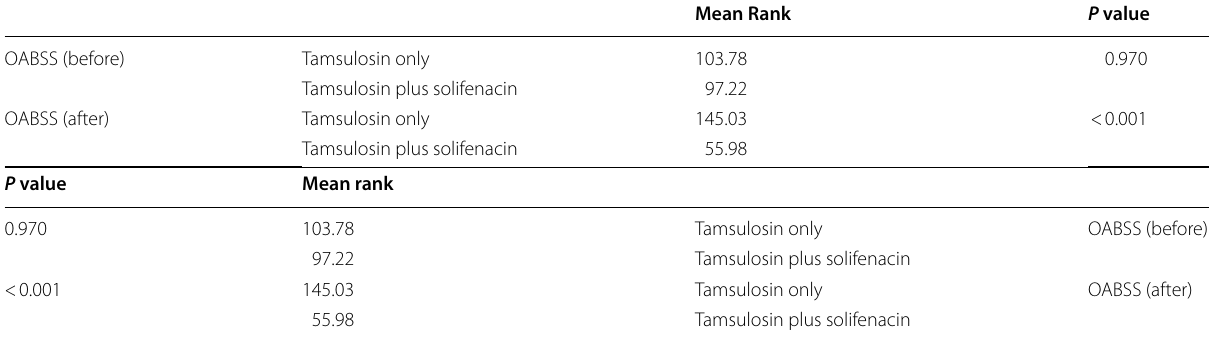
Table 6 Comparison between the change in OABSS in group A and group B